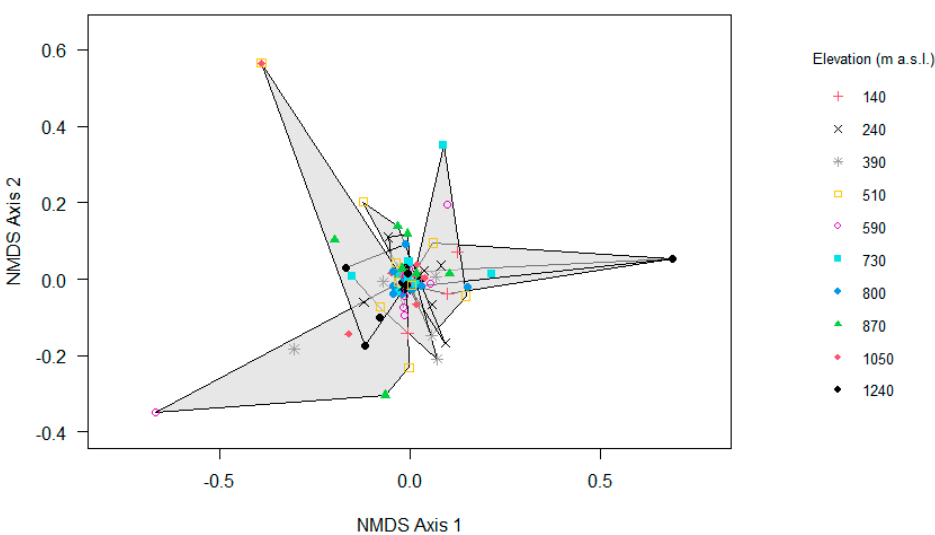
Figure 7. Non-metric multidimensional scaling (NMDS) ordination analyses of epiphyte assemblages on trees along the elevational gradient in Gualaca district, Panama ( n = 100). Stress value for NMDS is 0.16.